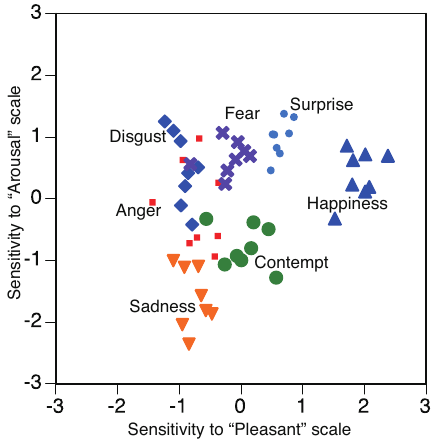
Figure 8. Mean IRT factor scores from “Affect Grid” rating scores in Figure